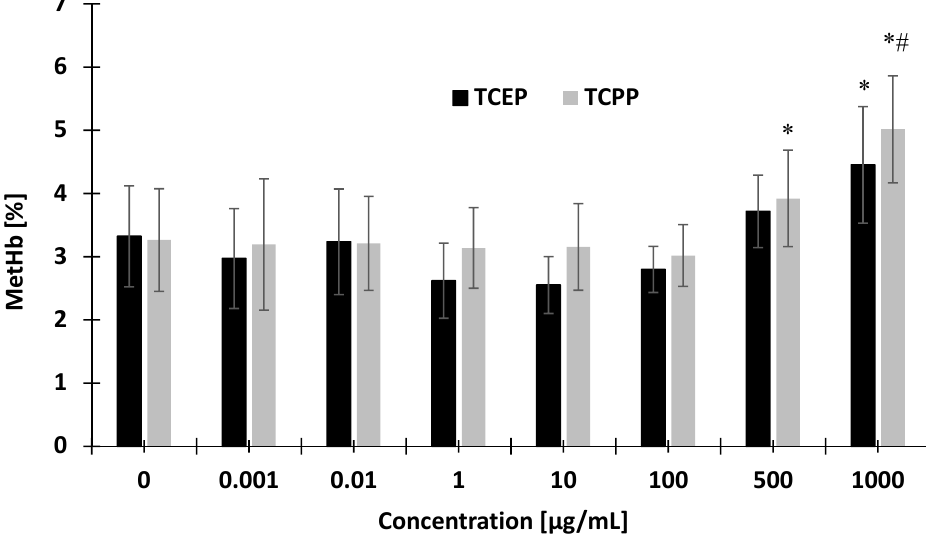
Figure 6. Changes in hemoglobin oxidation in control erythrocytes and erythrocytes incubated with TCEP and TCPP at concentrations ranging from 0.001 to 1000 µ g/mL for 24 h. * p < 0.05 indicates statistically significant difference from control; one-way ANOVA and a posteriori Tukey test. (#) statistically significant difference between TCPP and TCEP.